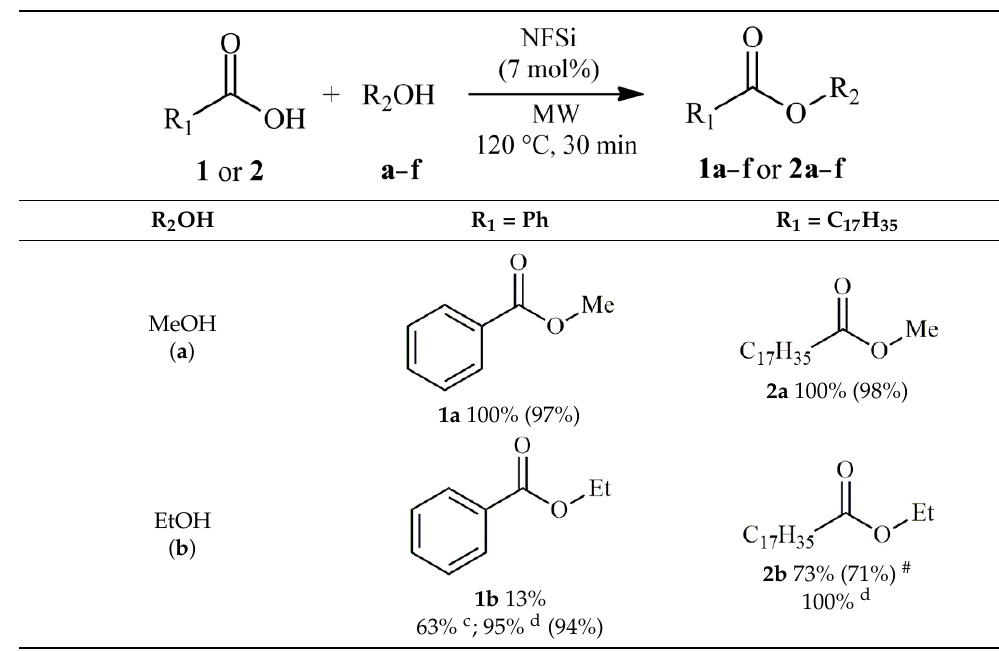
Table 2. The effect of alcohol structure on esterification of benzoic ( 1 ) and stearic acid ( 2 ) a,b .